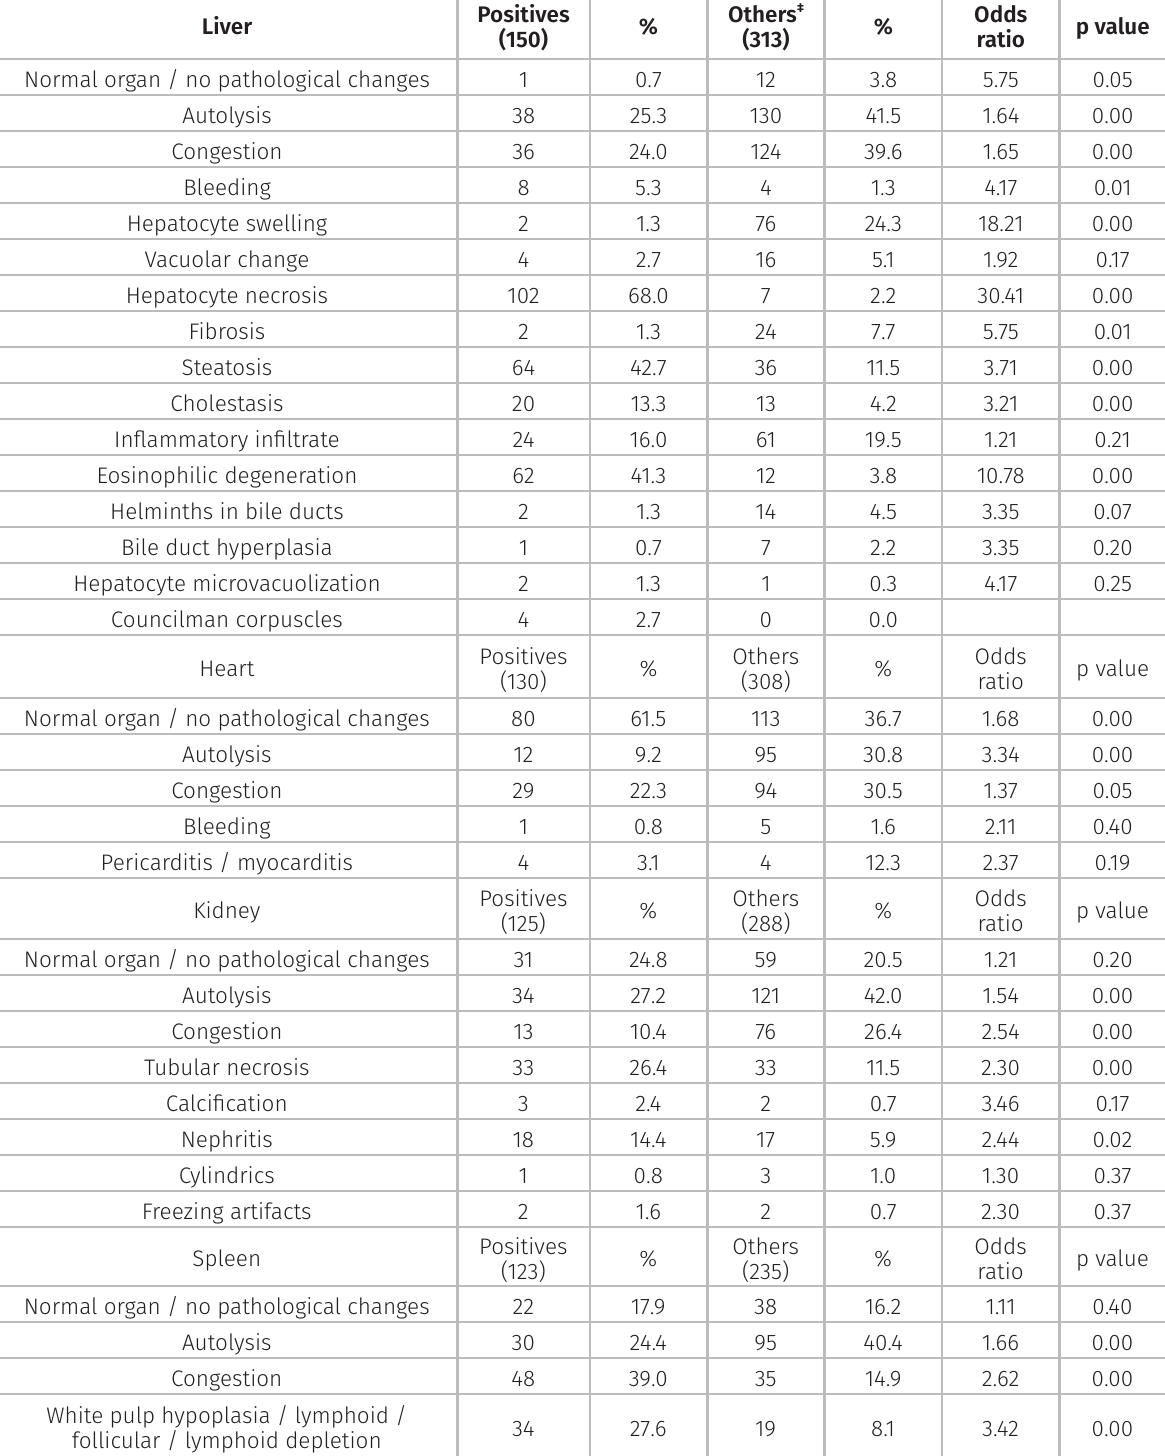
Table II. Frequency of main histopathological changes in non-human primates during and after the yellow fever virus outbreak in Espírito Santo, Brazil, from 2017 to 2020. Positives Liver